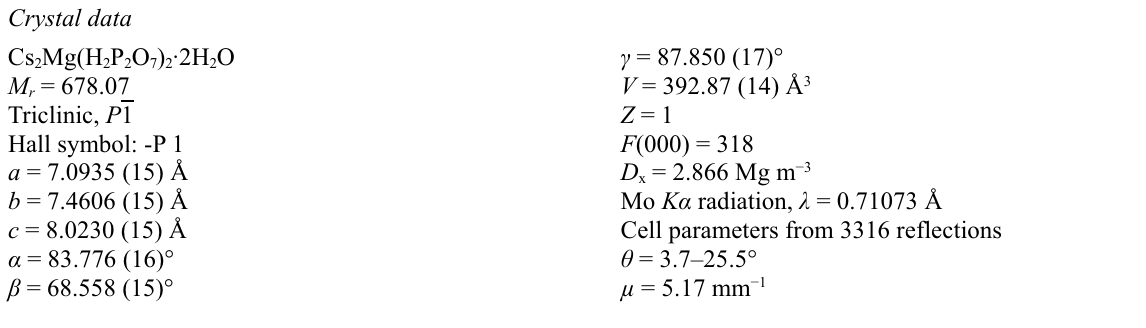
Mg coordination in Cs code: (i) - x ,- y , - z